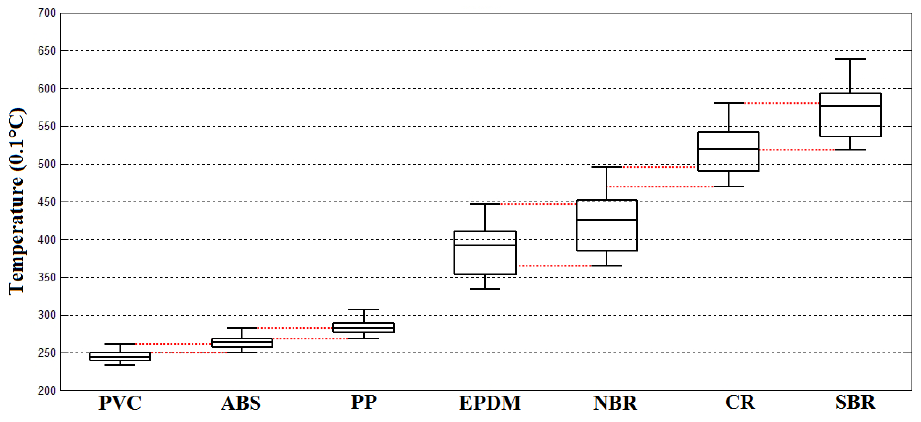
Figure 13. Distribution of temperature rises on tested polymer samples under microwave irradiation power of 6 kW.